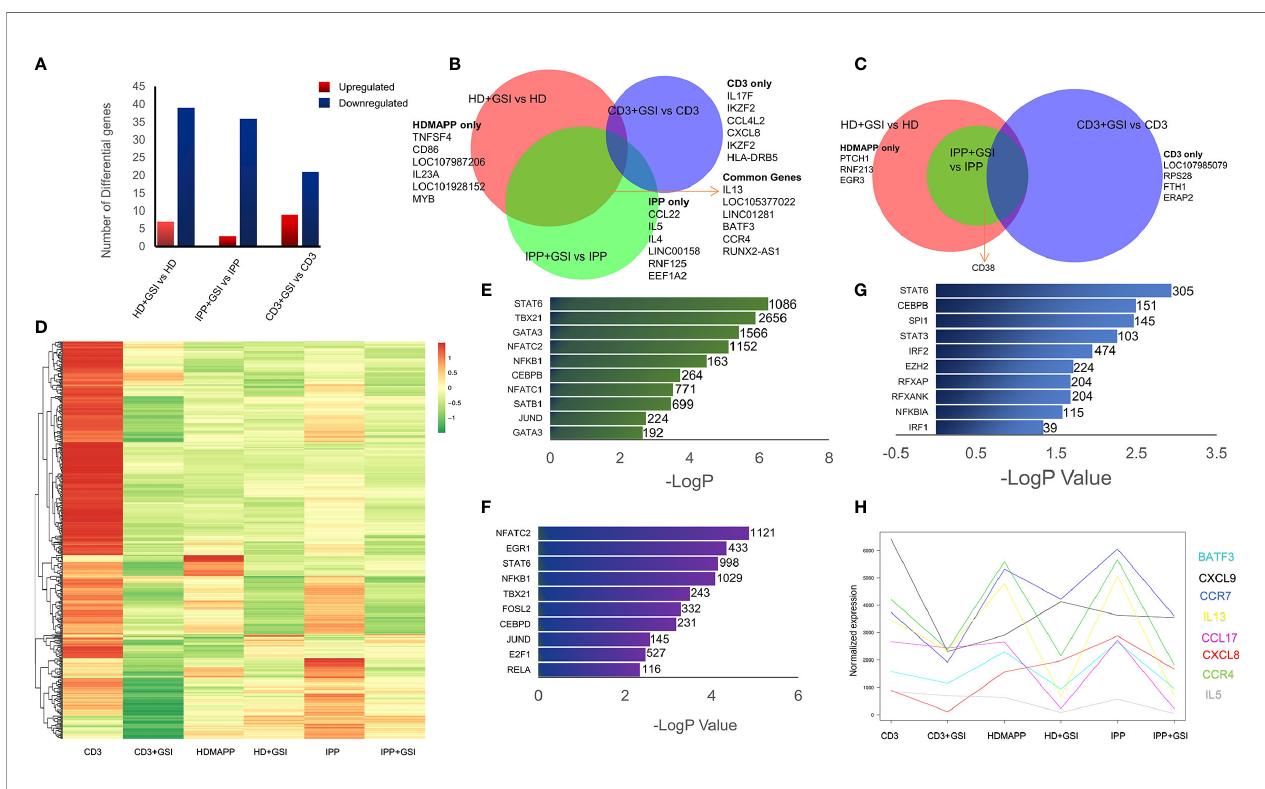
FIGURE 4 | Inhibition of Notch signaling disrupts effector signaling of gd T cells. (A) Total number of up- and downregulated genes in each activation vs corresponding activation + Notch-inhibition condition. DGE was performed with Wald ’ s test, logFC > 0.5 and FDR < 0.05. (B, C) Common genes down- and upregulated between each Notch inhibited dataset. Some of the key factors dysregulated are shown for both overlapping and individual treatments. (D) Heatmap showing differential clustering of gd T-cell-activating treatments and their combination with Notch inhibition (n = 3). (E – G) Enrichr analysis was performed on each DGE analyzed pair — IPP + GSI vs. IPP, HDMAPP + GSI vs. HD, and anti-CD3 + GSI vs. CD3, respectively. The most signi fi cantly affected TFs-mediated pathways are shown, ordered according to their − logP values. Combined Enrichr score is indicated for each factor as shown. (H) Normalized gene expression pro fi les for key cytokines across different activations and activations coupled with Notch inhibition (n = 3). Statistics was performed using the likelihood ratio test, with FDR <